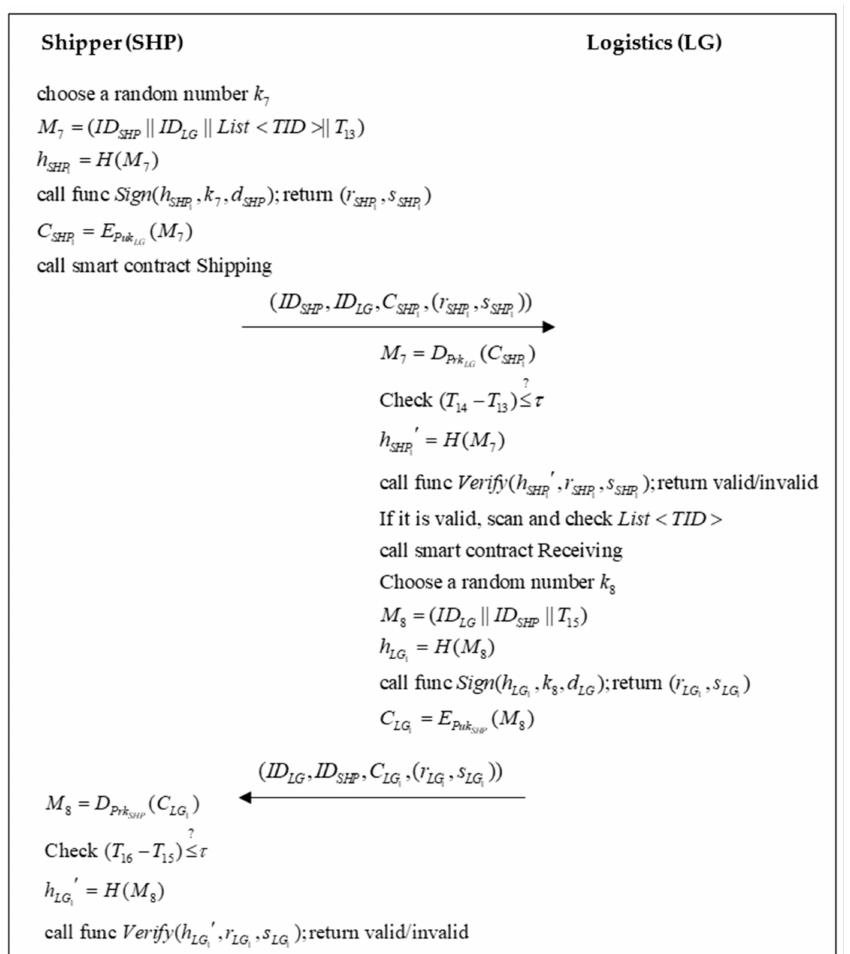
Figure 9. The flowchart of the logistics phase from shipper to